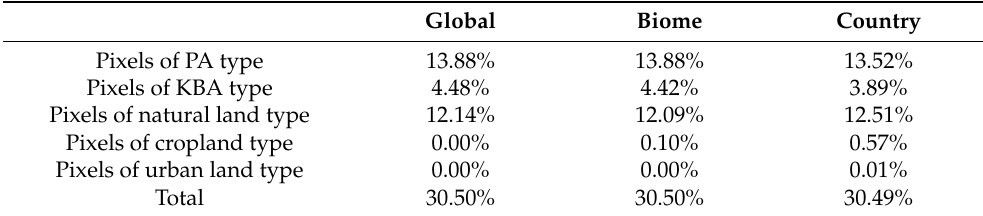
Table 1. 2030 nature-only: percentage of conserved area to global terrestrial area. Table 2. 2030 shared: percentage of conserved area to global terrestrial